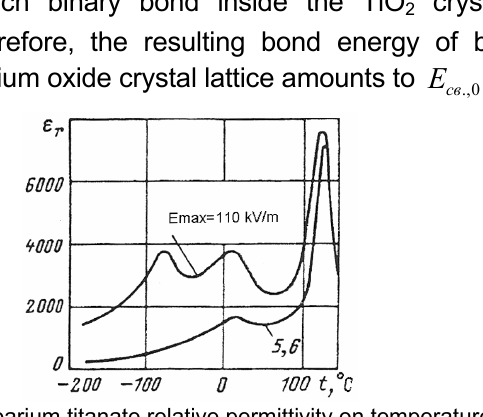
Fig. 3 – Dependence of barium titanate relative permittivity on temperature under applied electric field of 5.6 kV/m and 110 kV/m